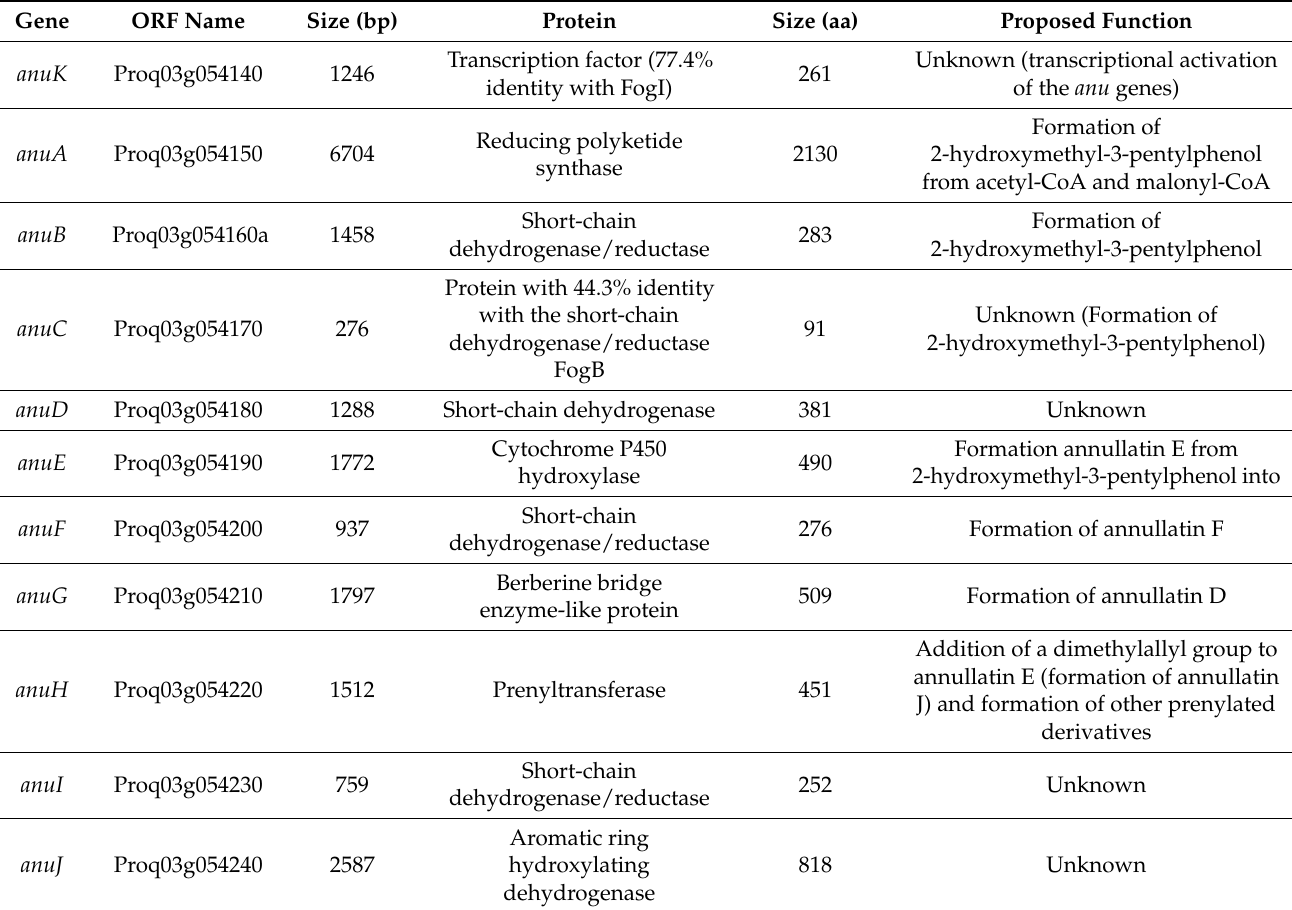
Table 6. Annullatins D and F biosynthetic gene cluster in P. roqueforti